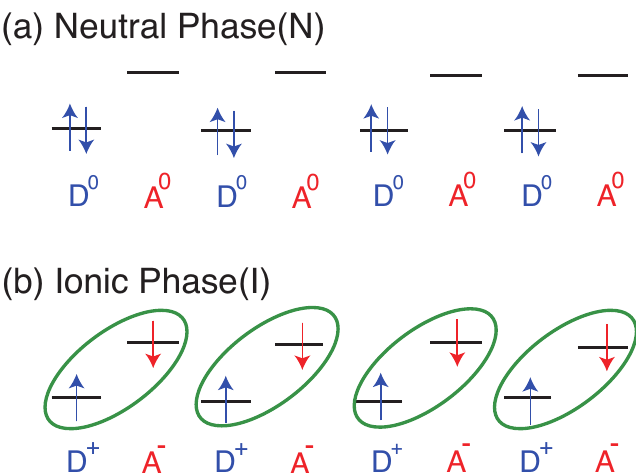
Figure 2. Schematics for a neutral-ionic-transition system. ( a ) The neutral phase and ( b ) the ionic phase. D and A mean a donor and an acceptor, which correspond to TTF and CA, respectively, for TTF-CA. The green oval indicates molecular